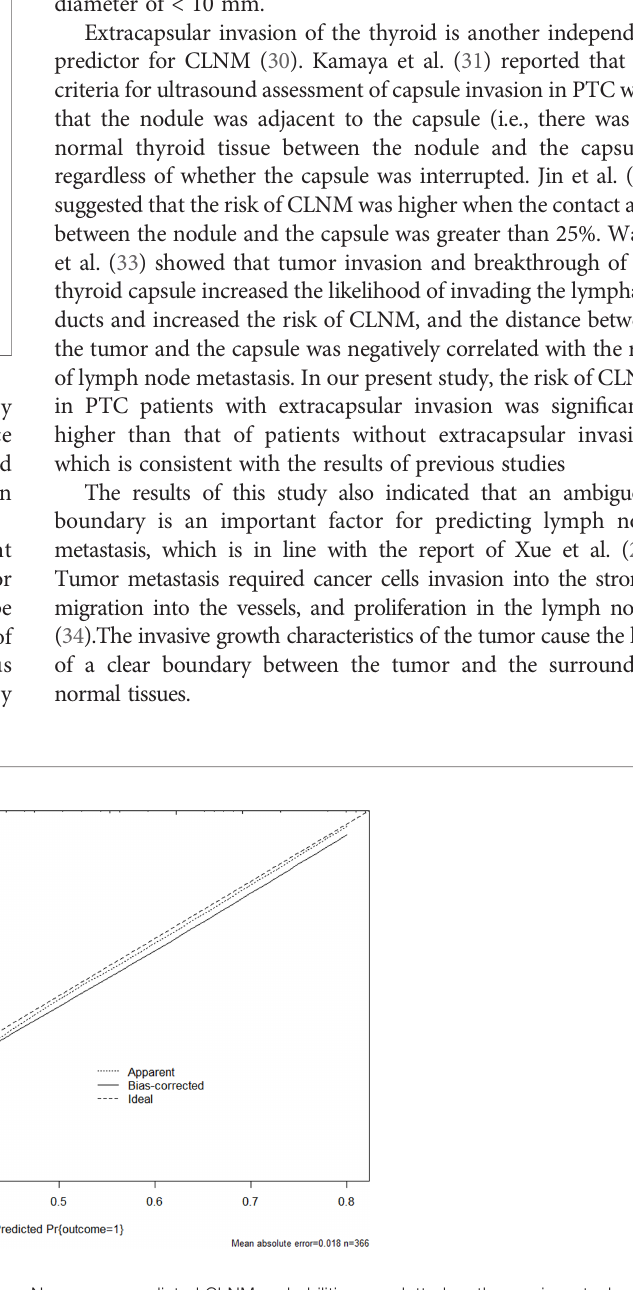
FIGURE 4 | Calibration curve for internal validation of the CLNM nomograms. Nomogram predicted CLNM probabilities are plotted on the x-axis; actual CLNM probabilities are plotted on the y-axis. The dashed line along the 45-degree line passing through the point of origin represents a perfect calibration model in which the predicted probabilities are consistent with the actual probabilities. US, ultrasound; CLNM, cervical lymph node